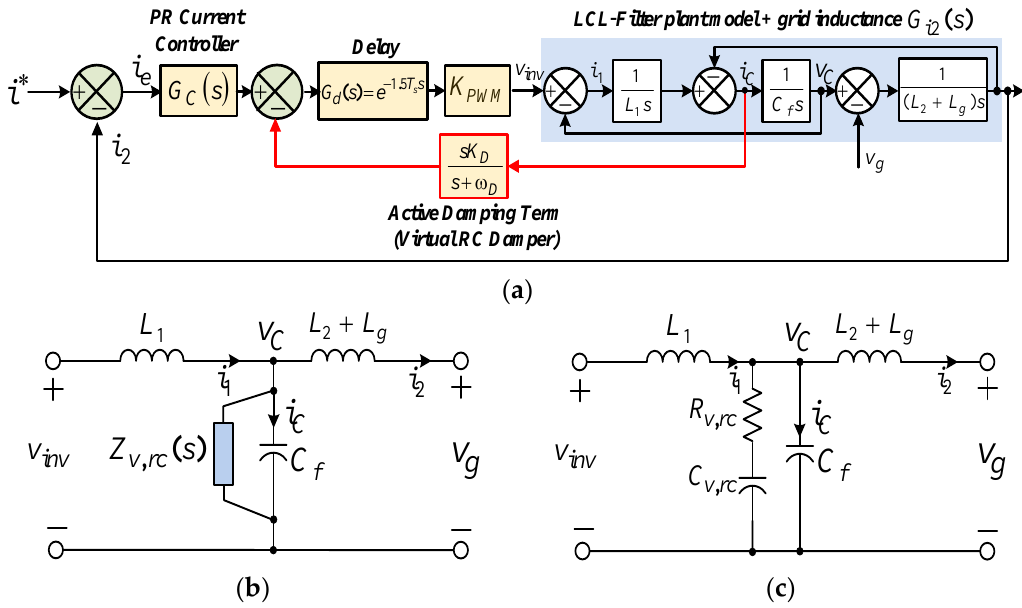
Figure 16. Block diagram and filter equivalent circuit for the first-order HPF-based CCF AD scheme: ( a ) control diagram representation; ( b ) filter equivalent circuit with delays considered; and ( c ) filter equivalent circuit without delays considered.